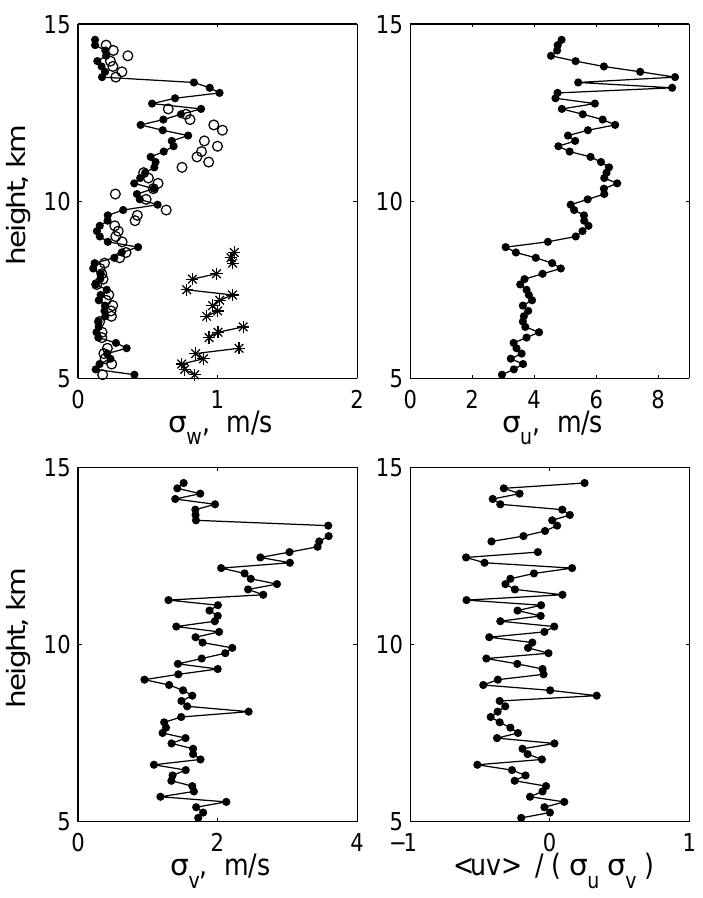
Fig. 7. The vertical profiles of turbulence characteristics above the MUR on 24 April 2002 at 21:51:26 LT. • , STARS; ◦ , HAD; ∗ , DBS.